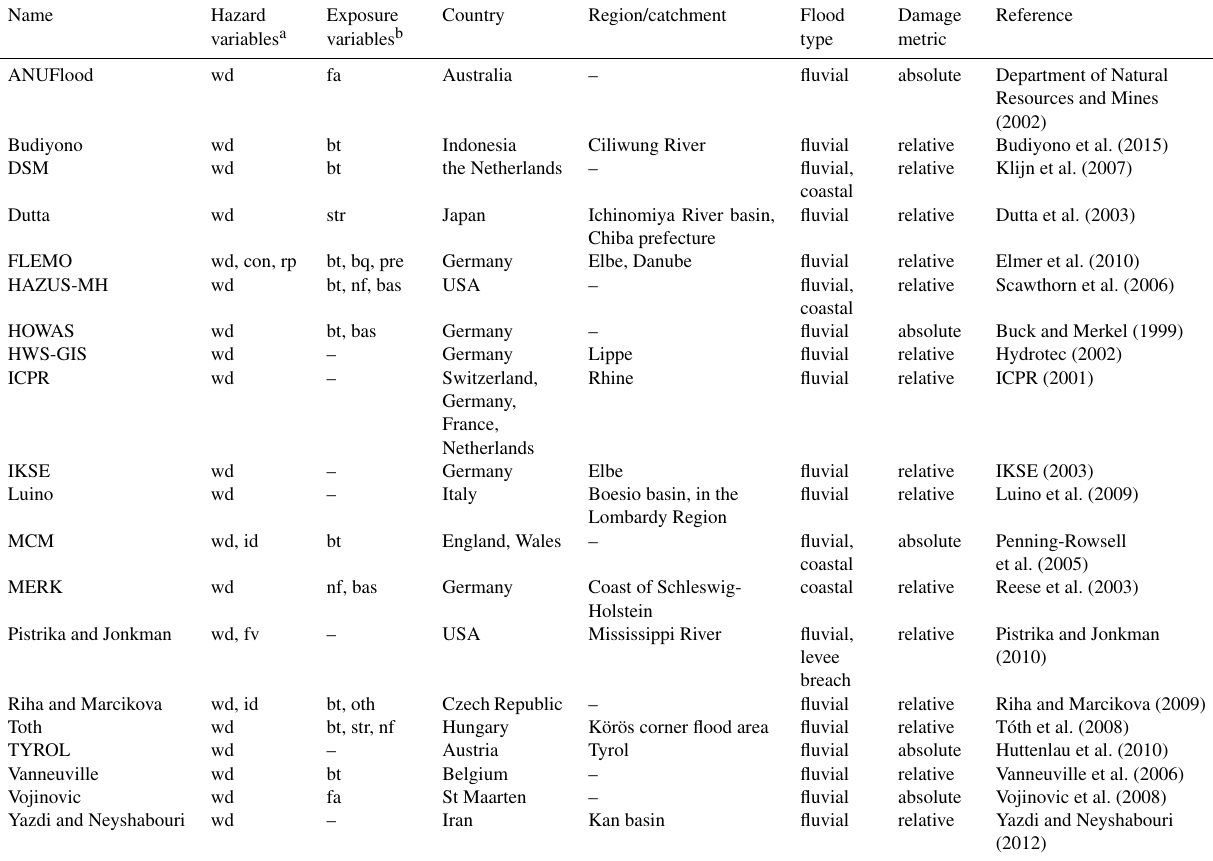
R. Figueiredo et al.: Multi-model ensembles for assessment of flood losses and associated uncertainty Table 1. Models included in this study, including some of their